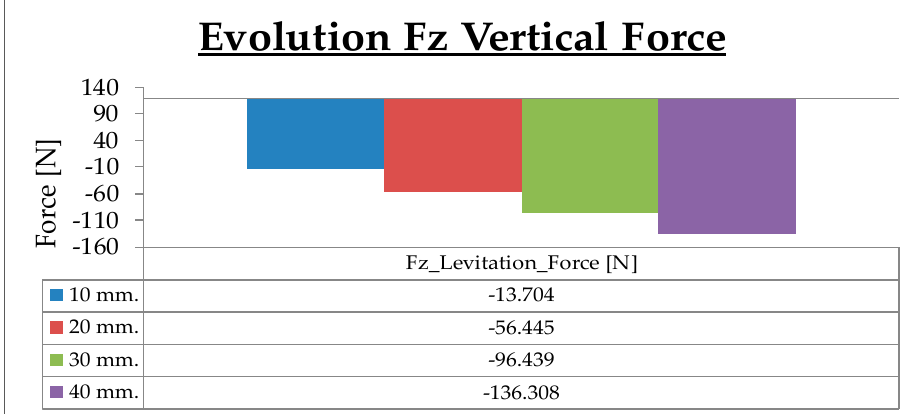
Figure 24. Levitation force in the transitory state with different values of the transversal slots.